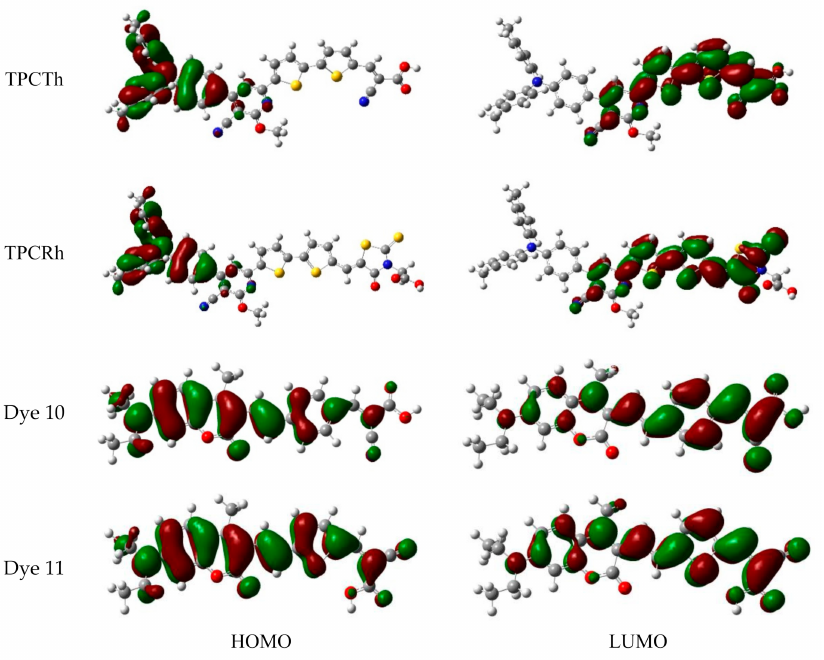
Figure 2. Frontier molecular orbital (FMO) diagrams of four original molecules.